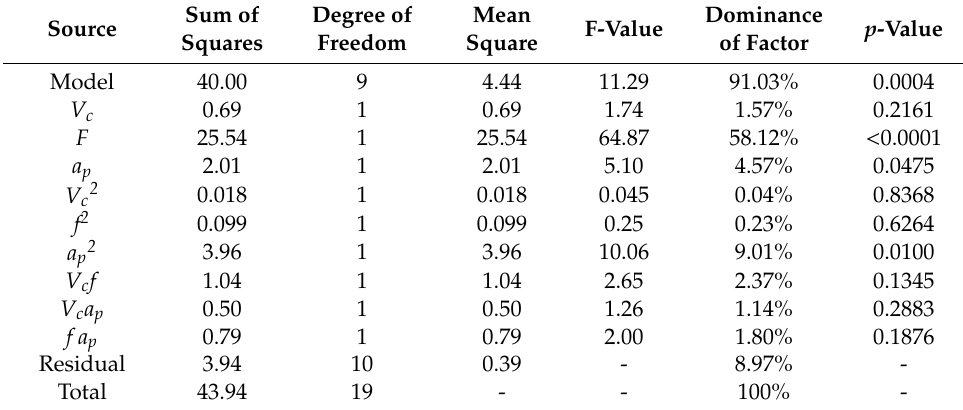
Table 8. ANOVA table for the maximum roughness height